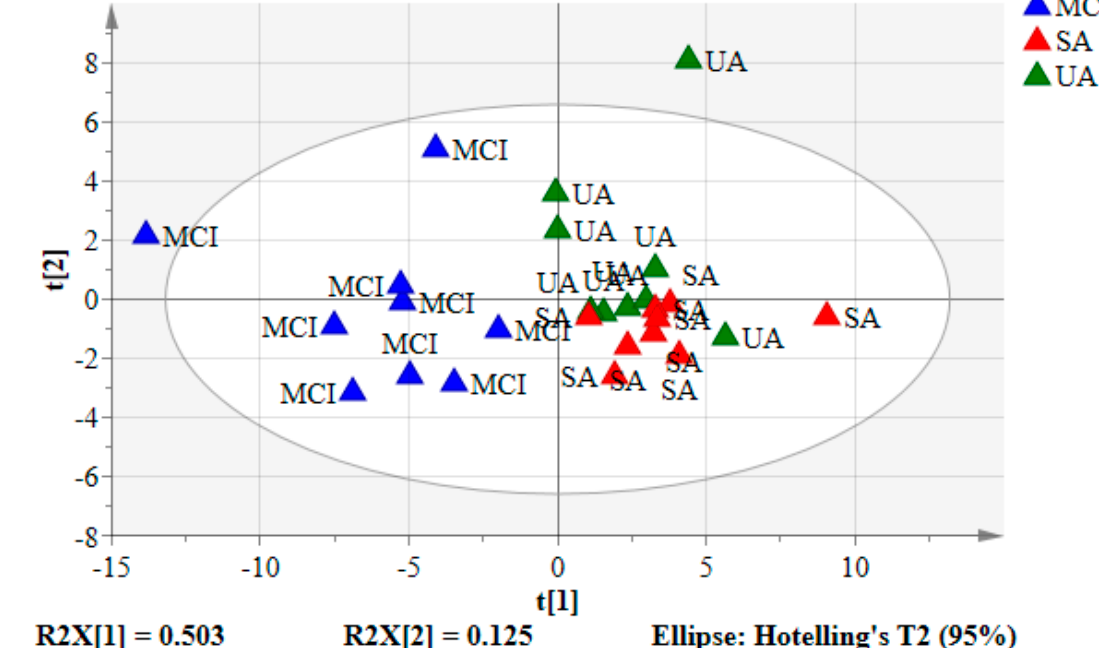
Figure 2. The PCA score plot of SA, UA, and MCI groups. Each point represented a single individual urine sample of the 1 H-NMR spectrum. Blue triangles: MCI, red triangles: SA, and green triangles: